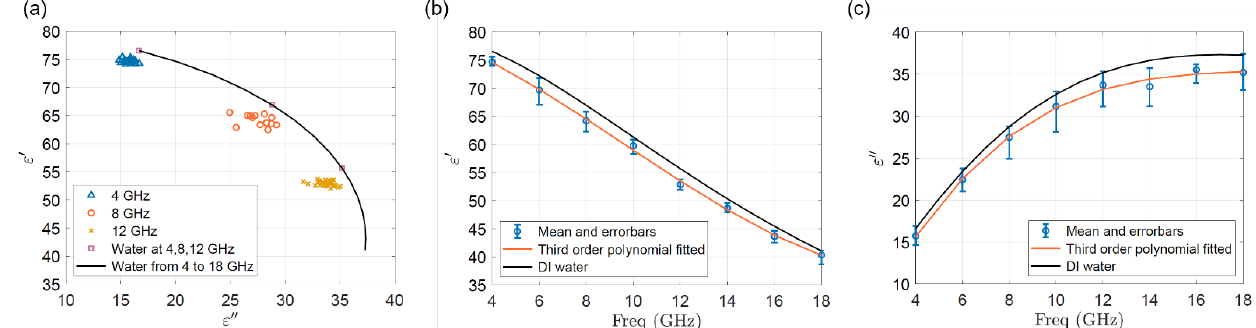
Figure 11. ( a ) The extracted data points at 4, 8, and 12 GHz in comparison to the complex permittivity of DI water at 20 °C [24]. ( b ) real ( ɛ ′ ) and ( c ) imaginary ( ɛ ″ ) permittivity of the single S288C yeast cells in the frequency range of 4 – 18 GHz at the room temperature of 20 °C. The blue error bars with mean values show the variations of the detection signals. The orange lines are the third-order polynomial fitting of the mean values. The black solid lines are complex permittivity of DI water at 20 °C.